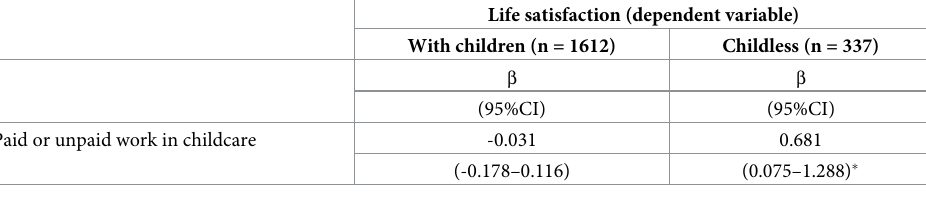
Table 5. Association of life satisfaction and work in childcare. Linear regression adjusted for sex and